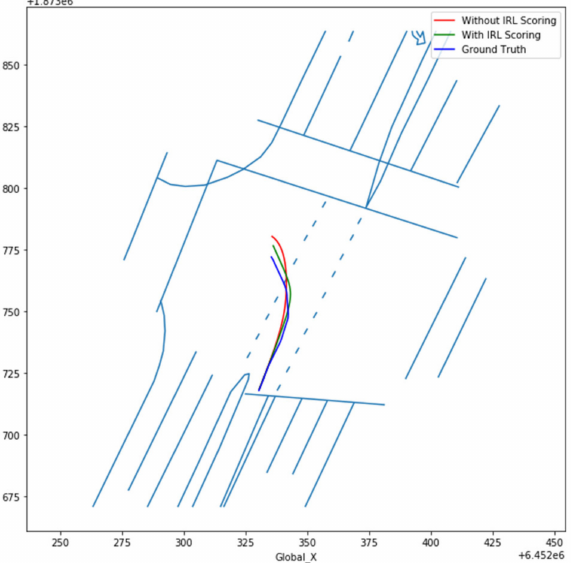
Figure 2. The trajectory of a left turn and the predictions of our method, reprinted from